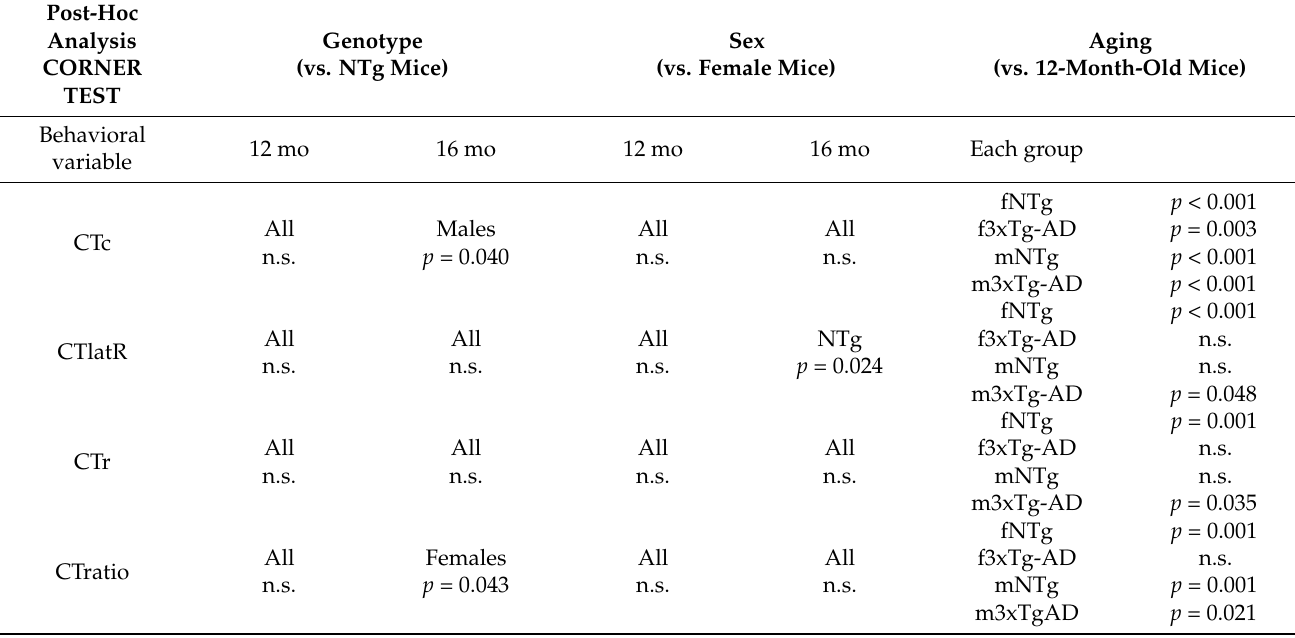
Table 1. Post-hoc analysis of genotype, sex, and aging differences in the corner